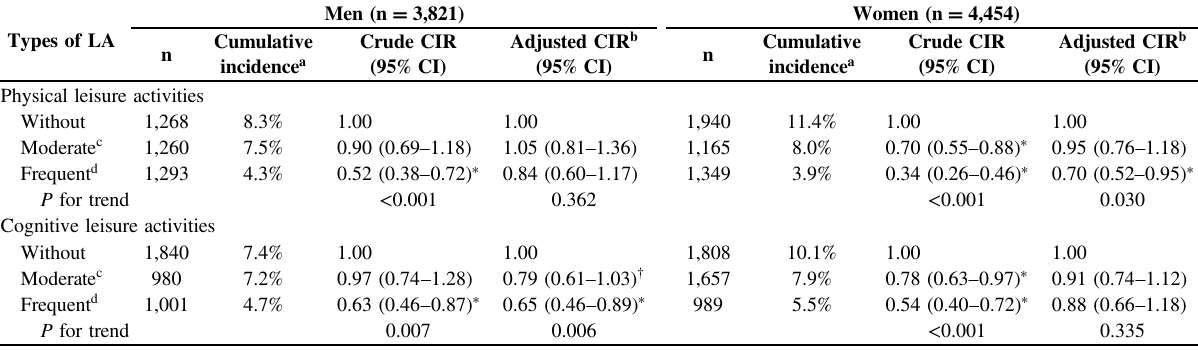
Table 4 Strati fi ed analyses by gender using the crude and fully-adjusted models Types of